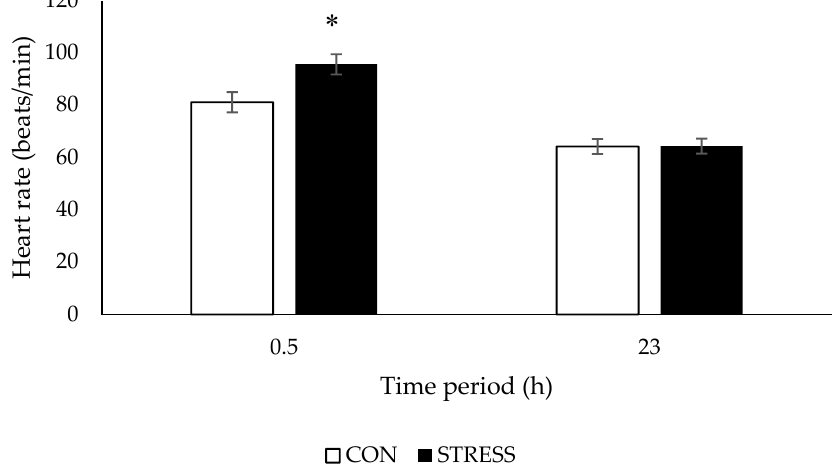
Figure 1. Heart rate (beats/min; means ± SED) of ewes housed in control (CON) or visually isolated pens (STRESS) during the first and last 30 min of a 23 h test period. * For a time period, least square means differ at p < 0.05.